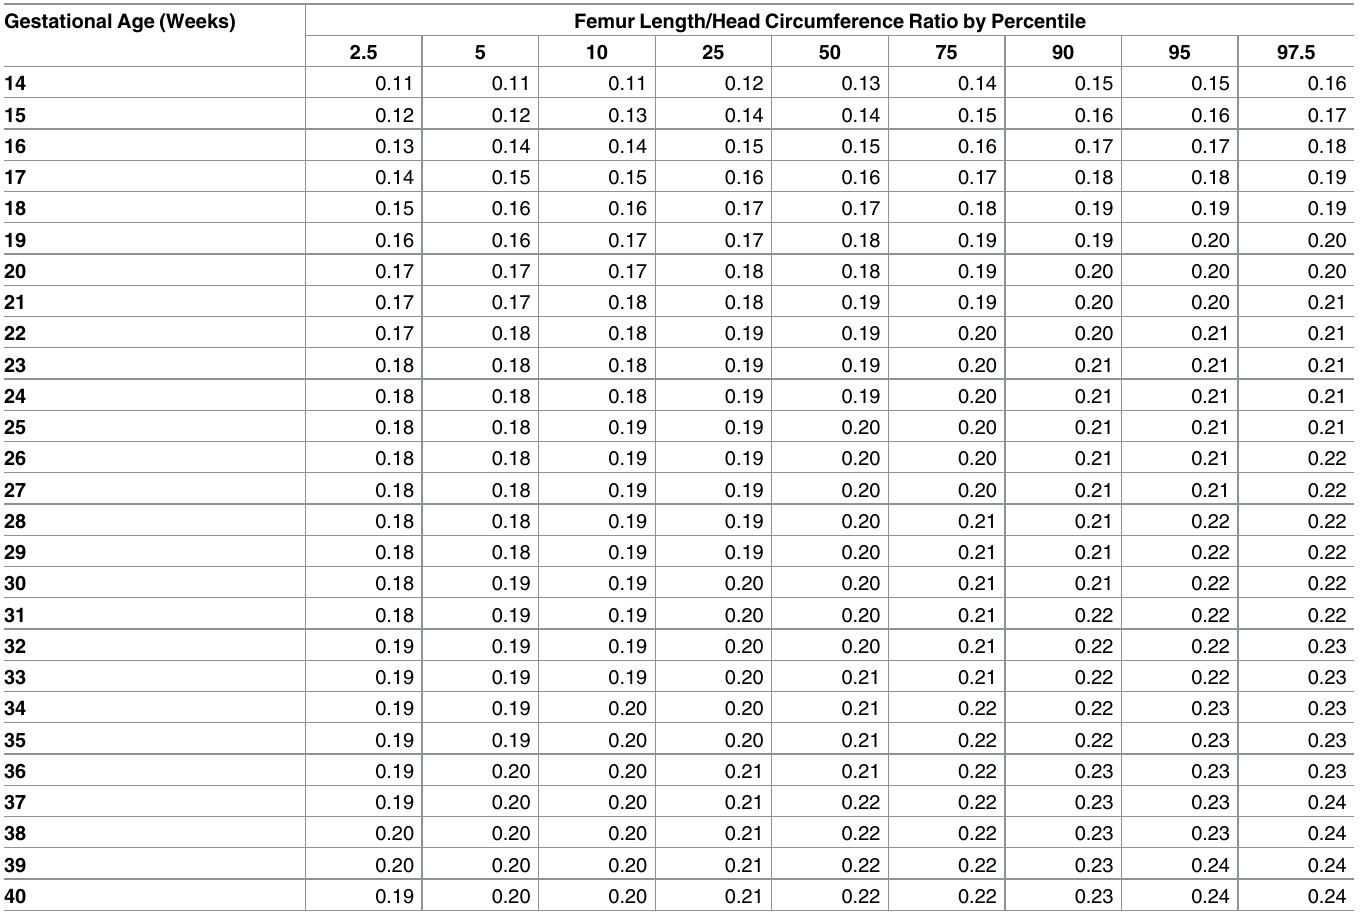
Table 13. Growth chart for fetal femur length/biparietal